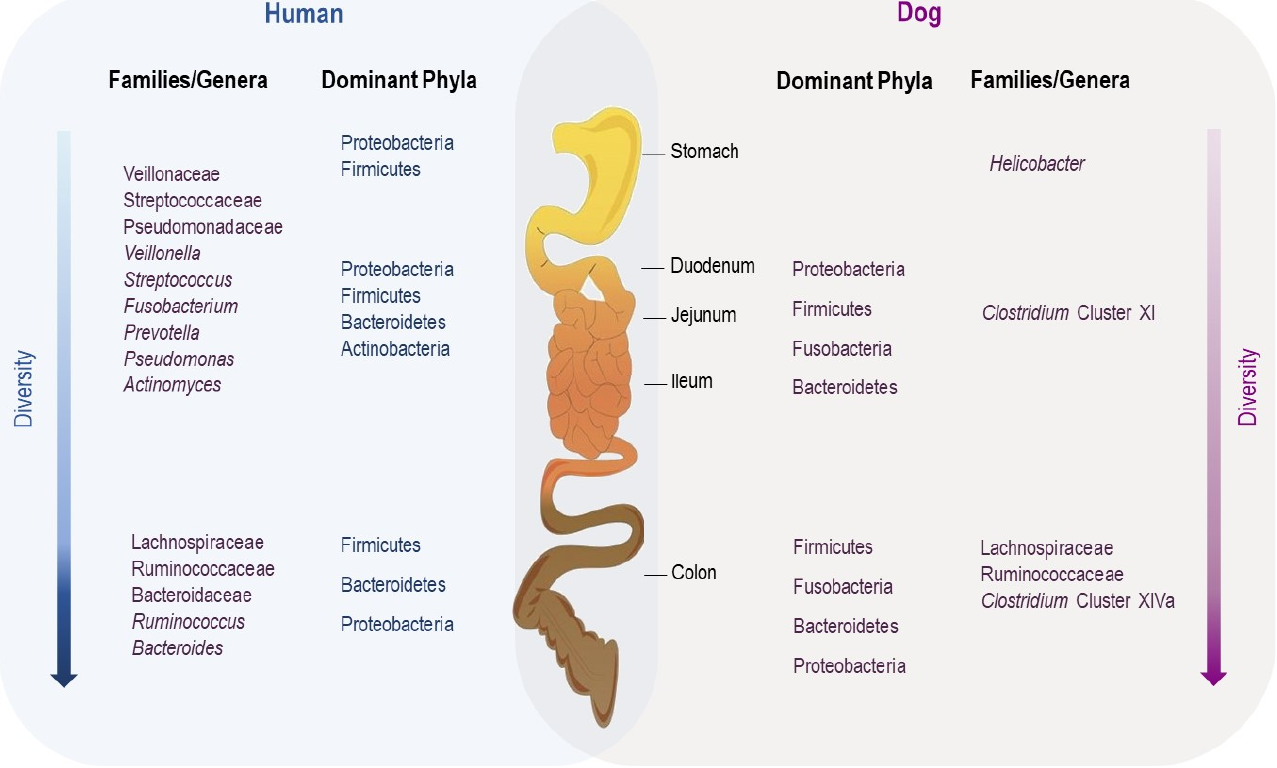
Figure 2. Comparative biogeography of the gut microbiota.